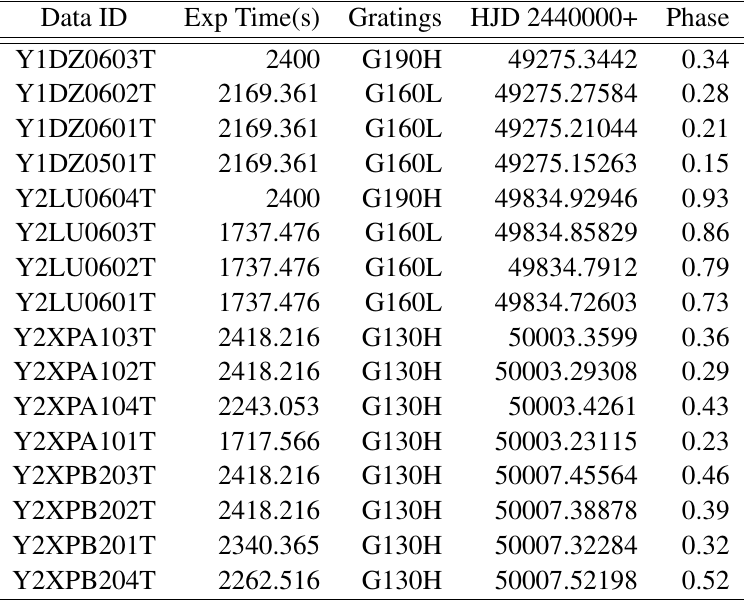
Table 2 List of HST observations for DQ